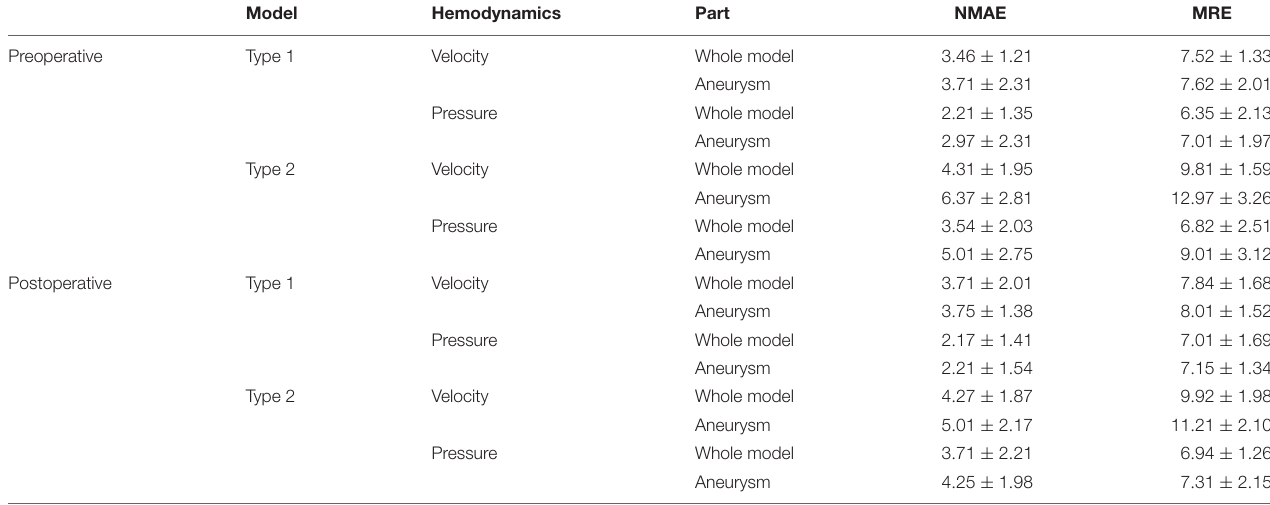
TABLE 3 | ERRs statistics results.